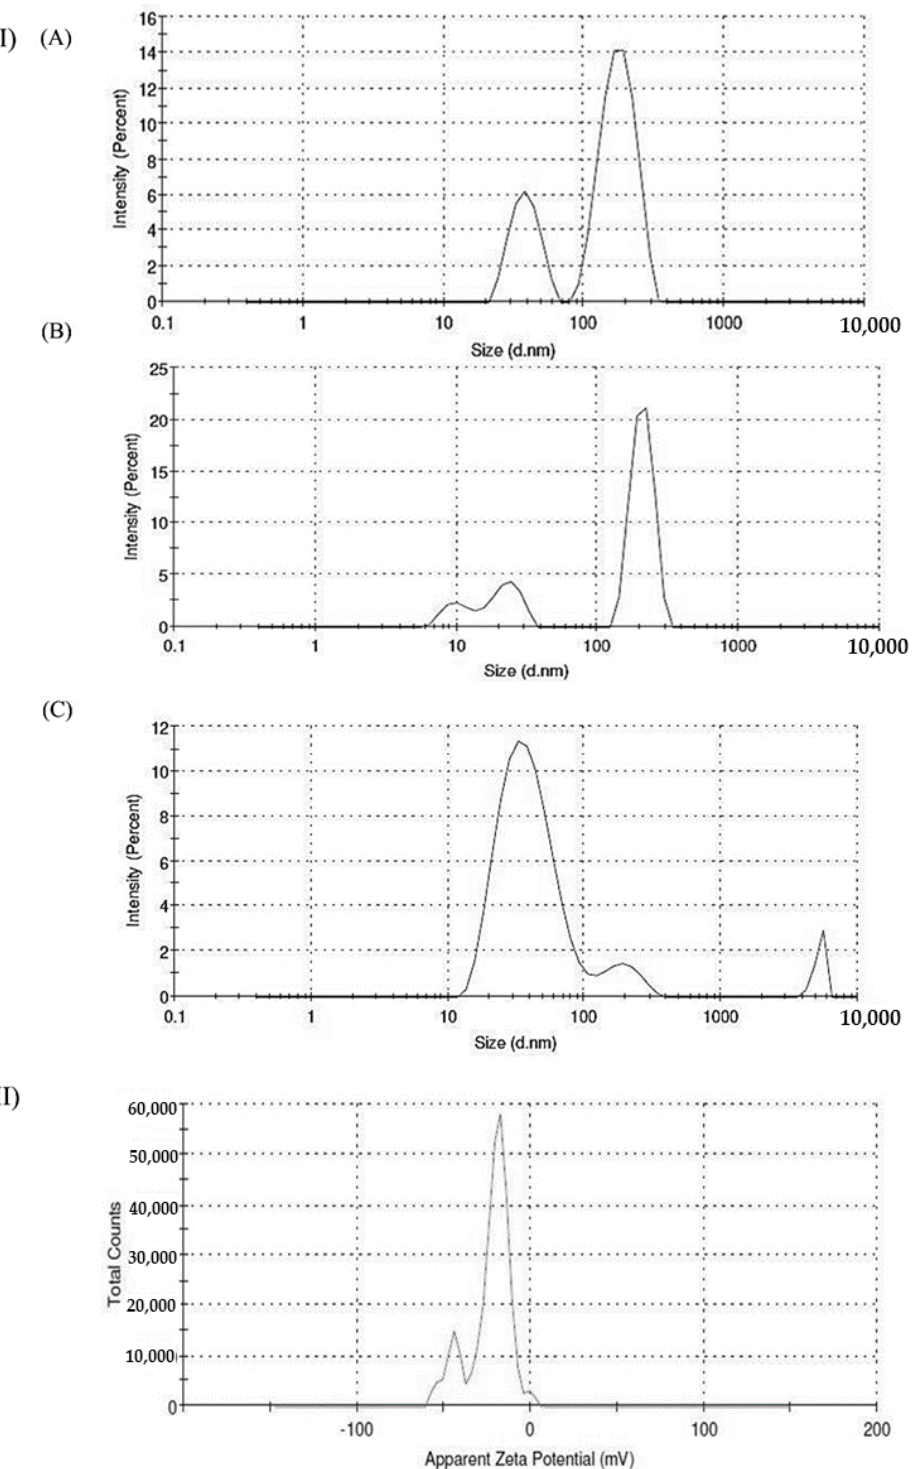
Figure 2. ( I ) DLS spectrum illustrating the particle size of AgNPs synthesized using various molar ratios of precursor and ( A ) AgNO 3 : L-histidine 1:1, ( B ) AgNO 3 : L-histidine 1:2, and ( C ) AgNO 3 : L-histidine 1:2.5; ( II ) zeta potential analysis of